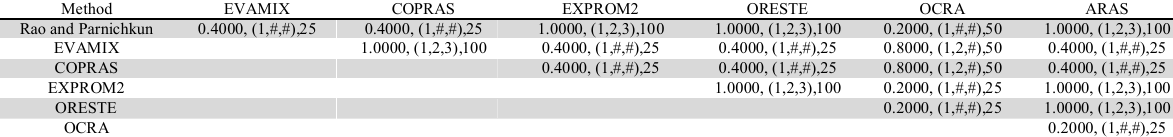
Performance test results of six preference ranking methods for example